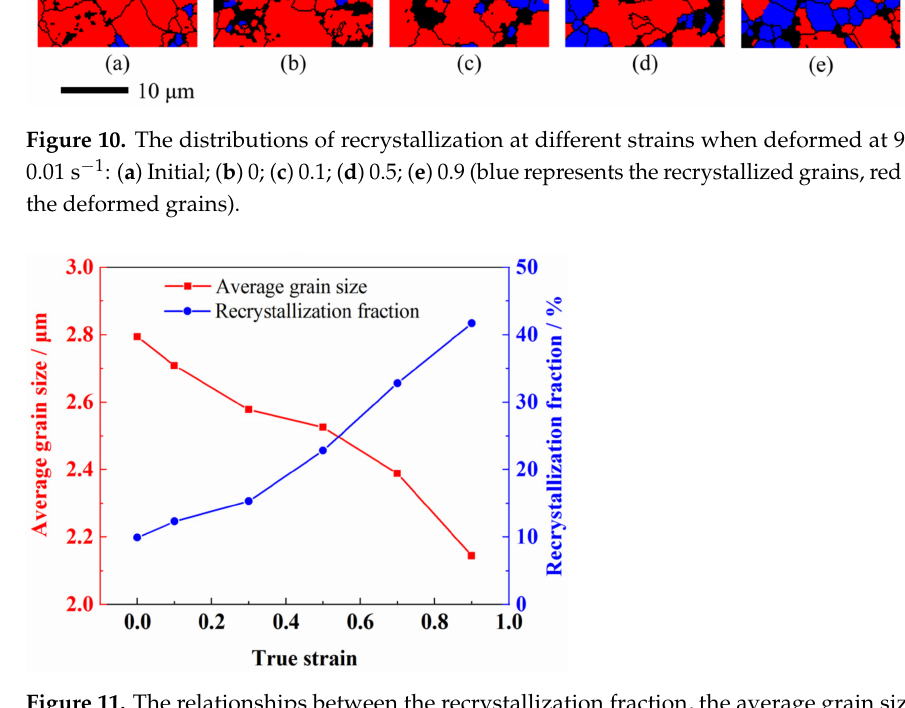
Figure 11. The relationships between the recrystallization fraction, the average grain size, and the true strain when deformed at 950 ◦ C and 0.01 s − 1